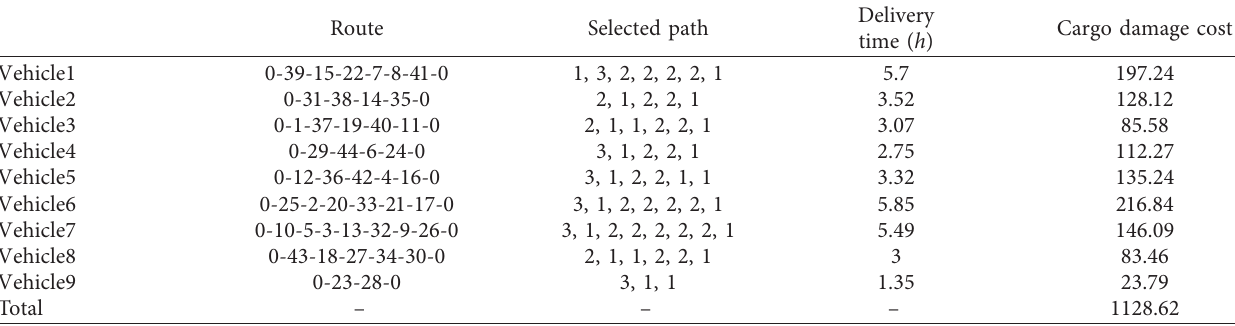
Table 8: Optimization results of delivery routes.